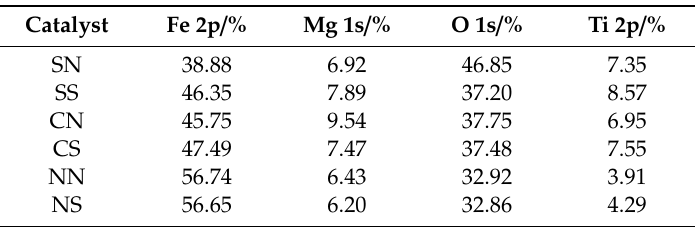
Table 5. X-ray photoelectron spectroscopy (XPS) elementary surface concentration of titanium modified FeMgO x catalysts with di ff erent